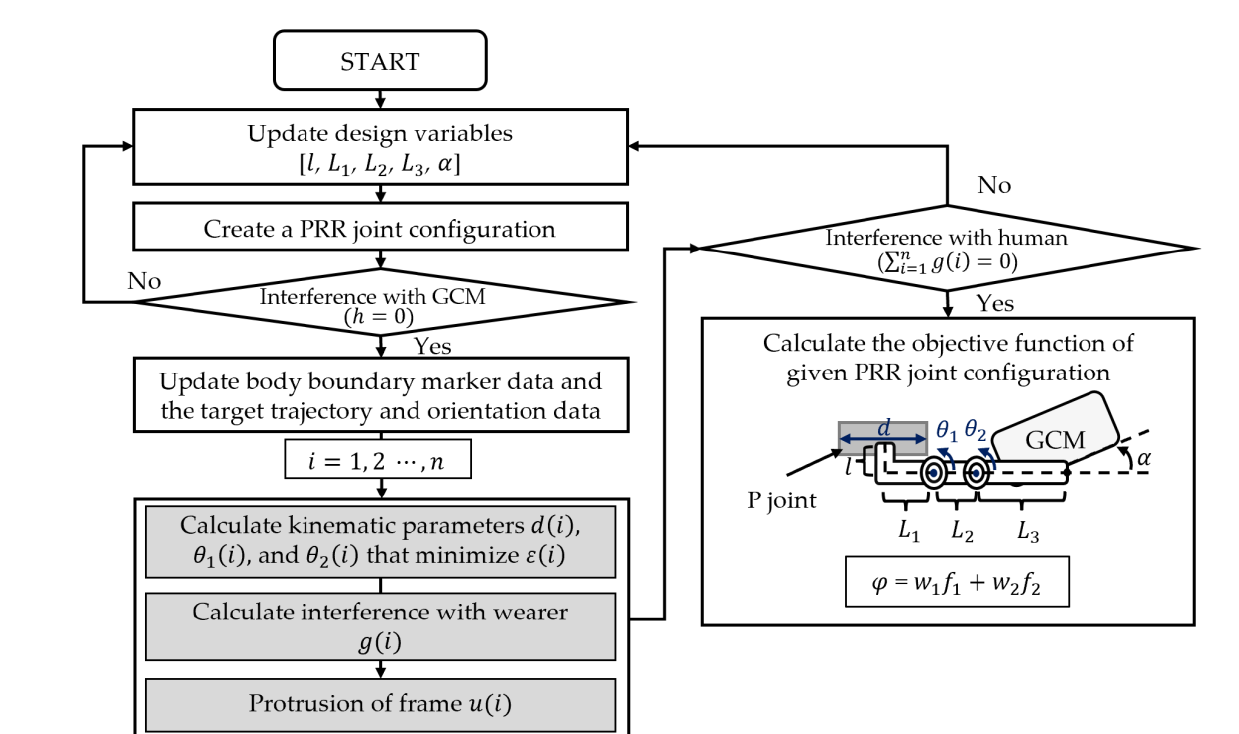
Figure 9. Process flow of calculating the objective function for a given PRR configuration.